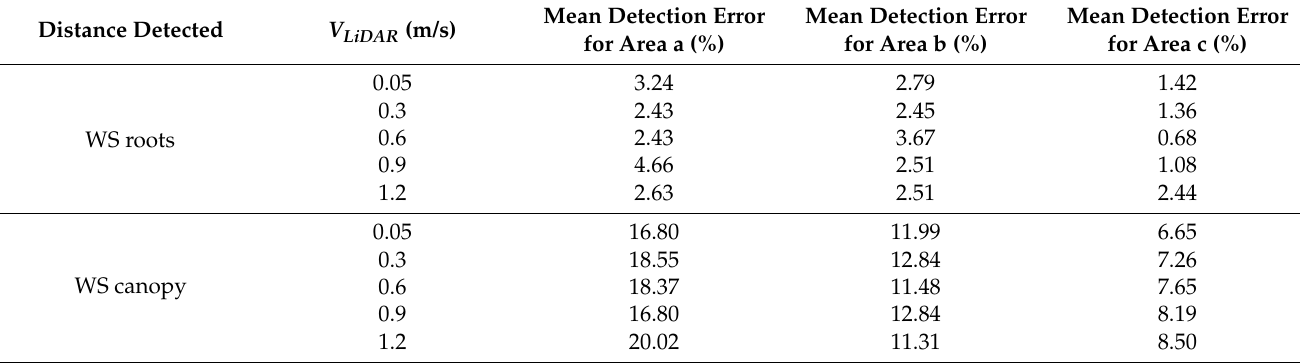
Table 3. Mean detection errors of the LiDAR sensor moving at different speeds for the WS roots and canopy in each area. Distance Detected V LiDAR (m/s)